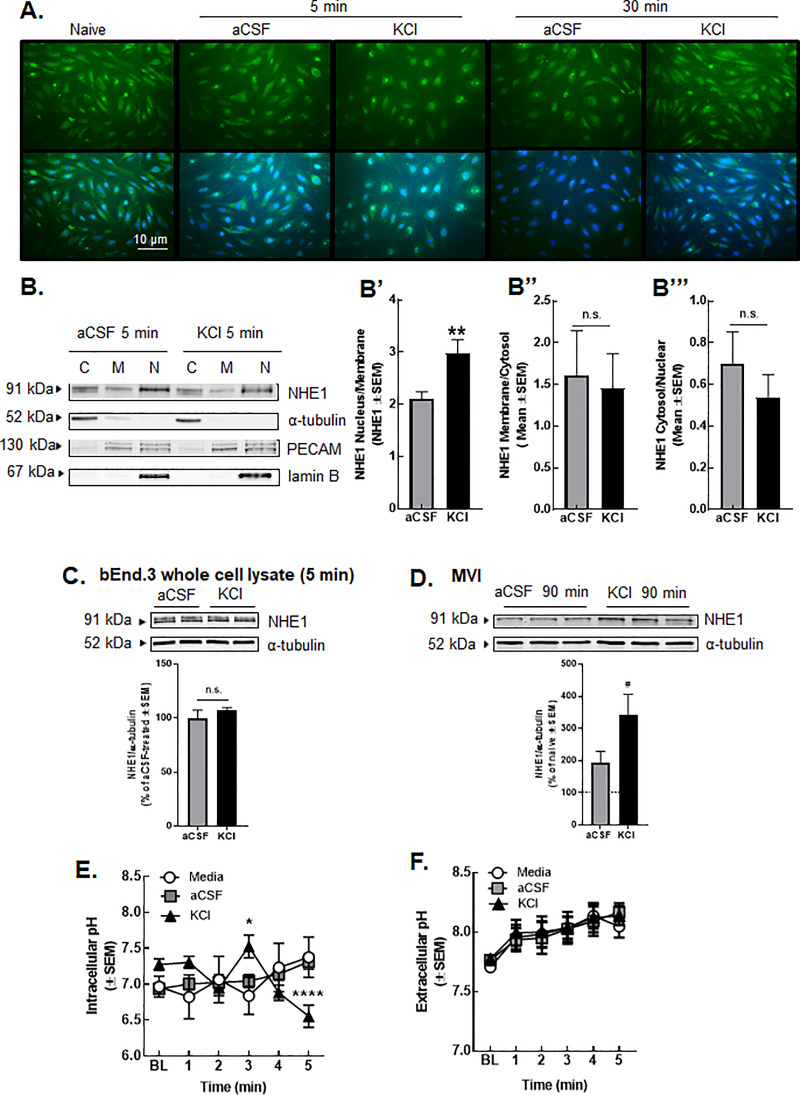
KCl pulse decreased membrane, but increased nuclear, detection of NHE1 in b.End3 endothelial cells.(A) Representative immunofluorescence images of bEnd.3 cells at two time-points after KCl or aCSF pulse. (B) Representative immunoblots of NHE1, α-tubulin, PECAM, and lamin B in cytosol, membrane, and nuclear fractions of bEnd.3 cells harvested at 5 min after KCl or aCSF pulse. (C = cytosol, M = membrane, N = nuclear) Values represent the mean ratio of NHE1 detection ± SEM (n = 11–12). (C) Representative immunoblots indicating NHE1 and α-tubulin as a loading control in whole cell lysate of bEnd.3 cells harvested at 5 min after KCl or aCSF pulse. Values represent the % of aCSF-treated relative expression ± SEM (n = 6). (D) Representative immunoblots of NHE1 and α-tubulin as a loading control in whole lysate of microvessels harvested at 90 min after cortical injection of KCl or aCSF. Values represent the % of naive relative expression ± SEM (n = 6). # denotes significantly different vs naïve (p<0.01), as assessed by one-way ANOVA (E) Intracellular pH during aCSF or KCl pulse. All data represent mean ± SEM (n = 45). (F) Extracellular pH during aCSF or KCl pulse. All data represent mean ± SEM (n = 6) in triplicate.